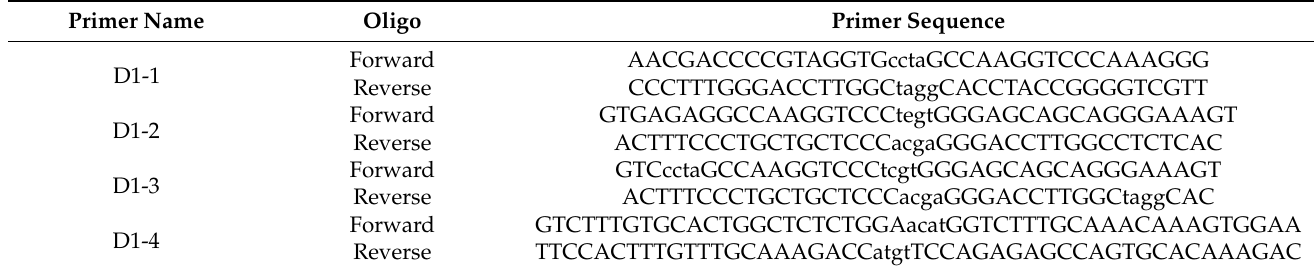
Table 2. Primer sequences used to generate the mutated PPRE and SRE on the PCSK9 pro- moter. Nucleotides in bold and small caps indicate the introduced point mutations. D1-1, D1-2, D1-3, and D1-4 were the primer sets used to introduce mutations of PPRE at location − 1509/ − 1506, PPRE at − 1494/ − 1491, two PPREs at − 1509/ − 1506 and − 1494/ − 1491, and SRE at − 1229/ − 1226,